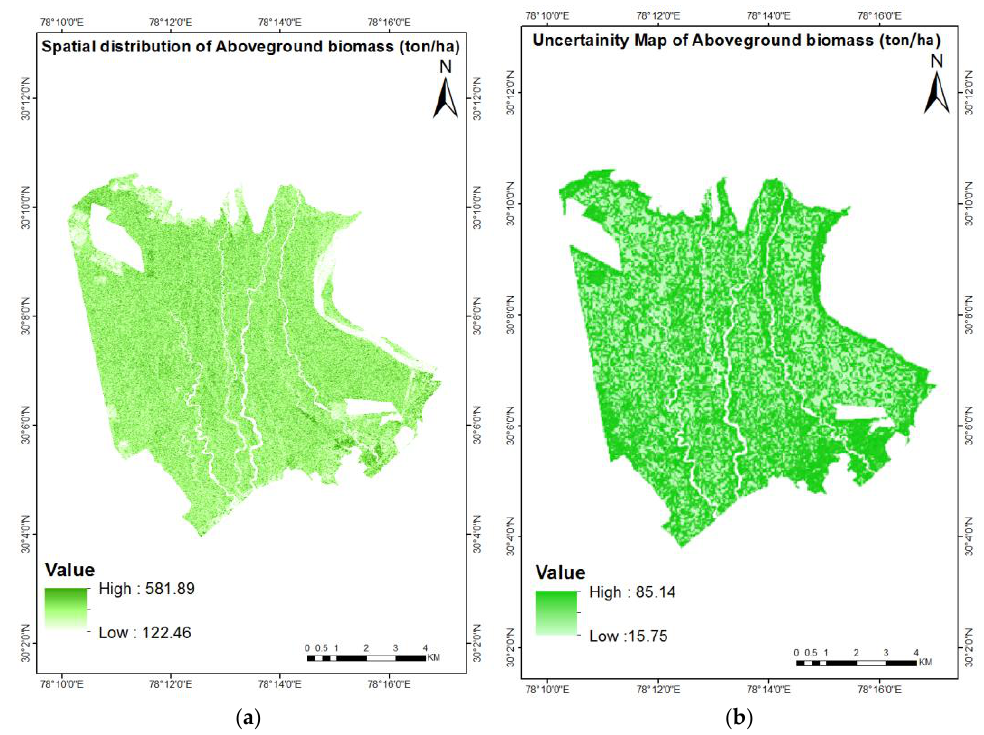
Figure 12. Visualization of the ( a ) spatial distribution of AGB (t/ha) and ( b ) uncertainty of AGB